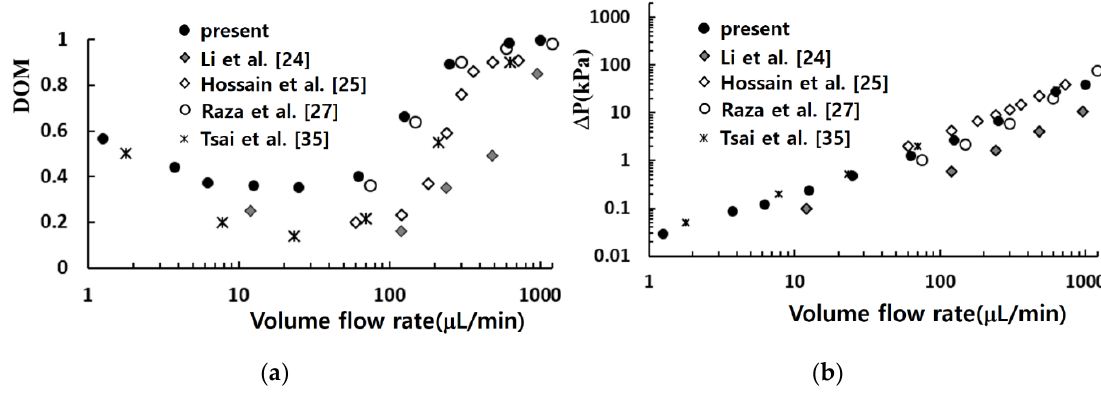
Figure 5. Variation of the degree of mixing (DOM) ( a ) and pressure load ( b ) with the volume flow rate.